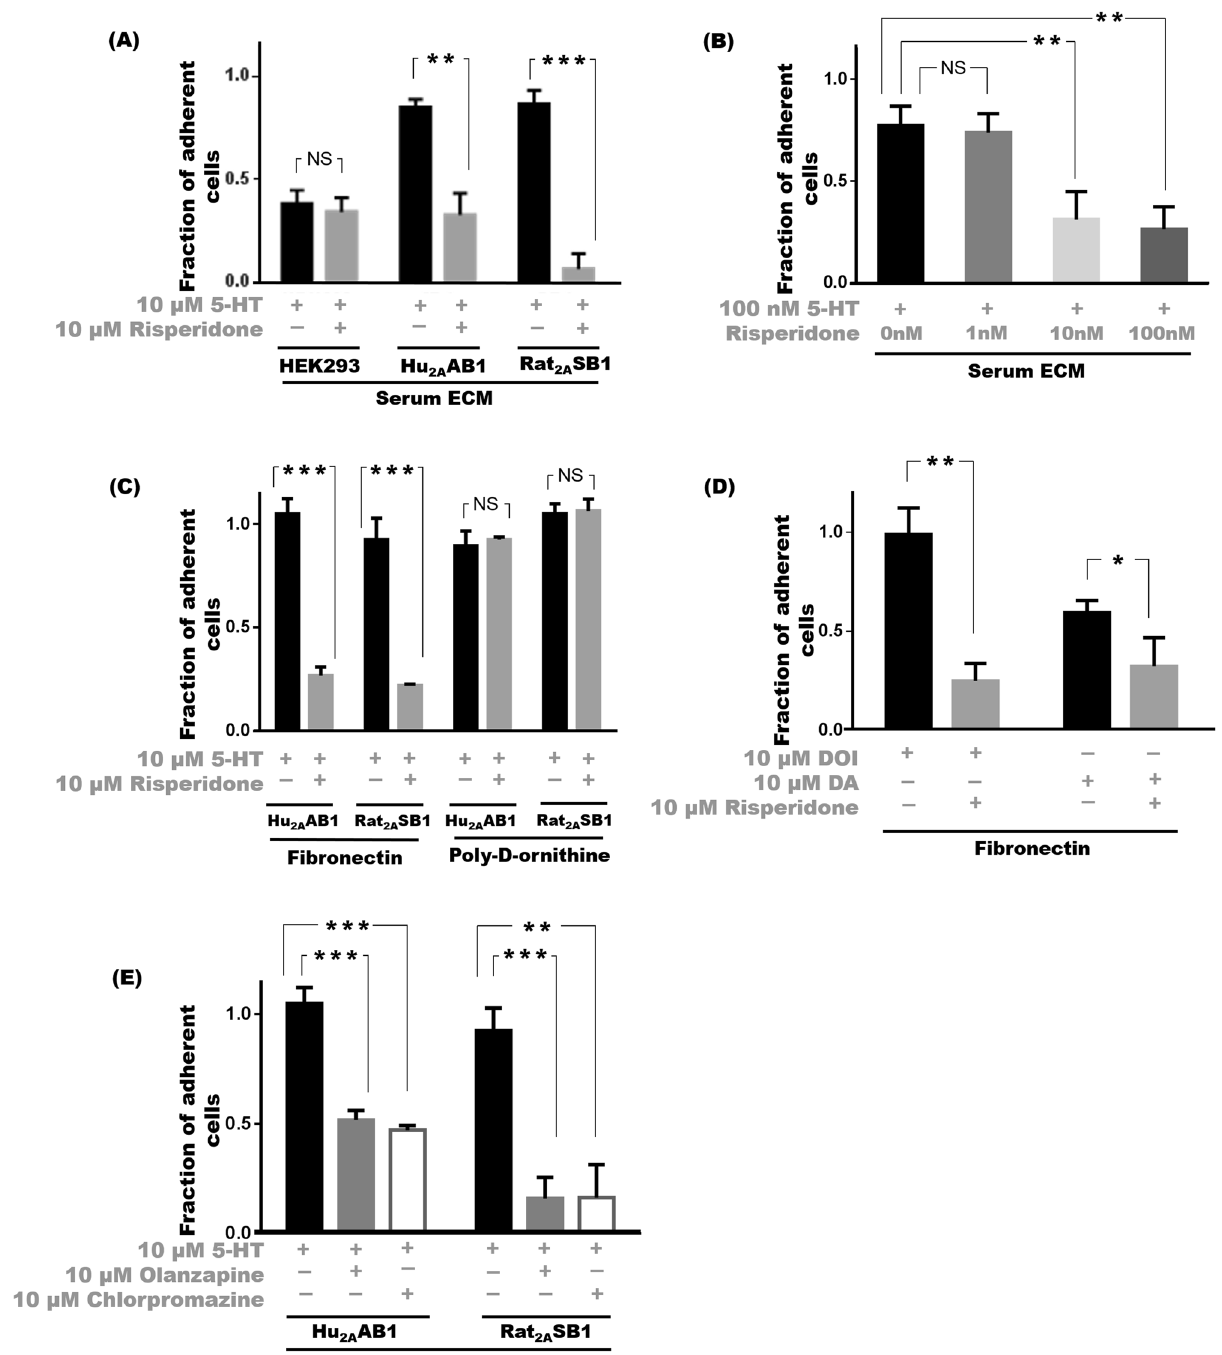
Figure 3. Inhibition of 5-HT 2A by antipsychotics leads to loss of adhesion. ( A ) Cell adhesion profile of HEK293 cells, Hu 2A AB1 or Rat 2A SB1 cells treated with 10 µM risperidone and 10 µM 5-HT compared to 10 µM 5-HT treatment alone on serum ECM substrate. ( B ) Cell adhesion profile of Hu 2A AB1 cells treated with varying concentration of risperidone—1 nM, 10 nM or 100 nM, in the presence of 100 nM serotonin compared to 100 nM 5-HT treatment alone on a serum ECM substrate. ( C ) Cell adhesion profile of HEK293, Hu 2A AB1 and Rat 2A SB1 cells in the presence of 10 µM risperidone and 10 µM 5-HT compared to control cells treated only with 10 µM 5-HT treatment on fibronectin or poly-d-ornithine substrates. ( D ) Cell adhesion profile of Hu 2A AB1 cells treated with 10 μM risperidone along with either 10 μM DOI or 10 μM dopamine (DA) compared to their respective controls without risperidone on a fibronectin substrate. ( E ) Cell adhesion profile of Hu 2A AB1 and Rat 2A SB1 cells with 10 μM olanzapine or 10 μM chlorpromazine and 10 µM 5-HT treatments compared to 10 µM 5-HT treatment alone, on fibronectin substrate. Error bars represent SD values. The data represented by the gray bars are compared against the respective black bars by two tailed students t test; p value less than 0.05 is considered significant. The corresponding p value for the asterisks are *p < 0.05, **p < 0.01, ***p < 0.001, NS p >